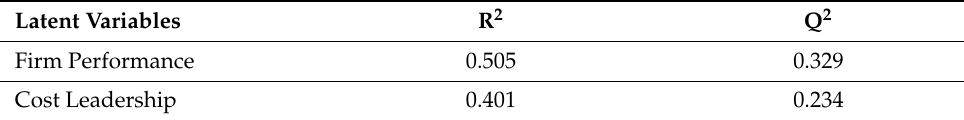
Table 8. R2 and Q2